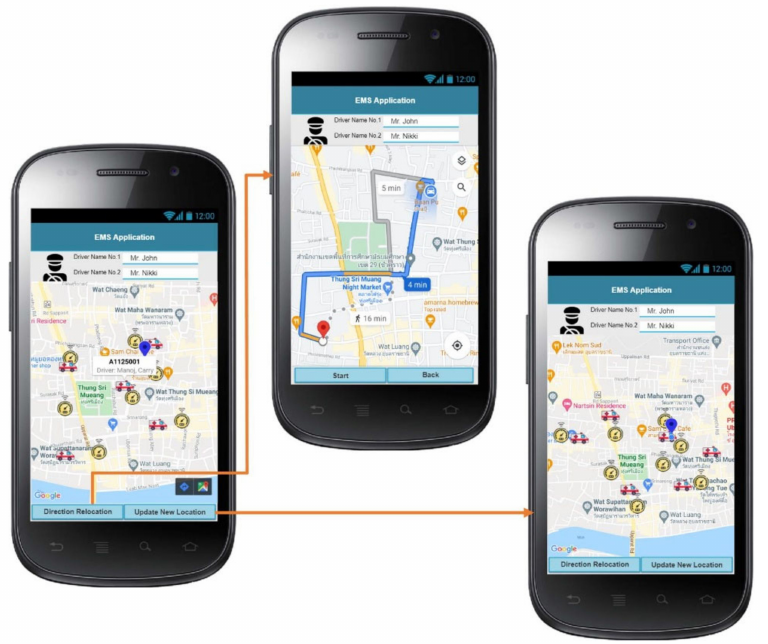
Figure 3. User interface EMS application